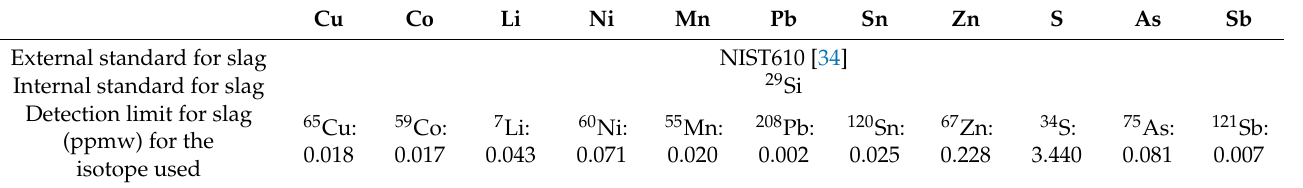
Table 3. LA-ICP-MS standards and obtained detection limits for the isotopes used in this work. Cu